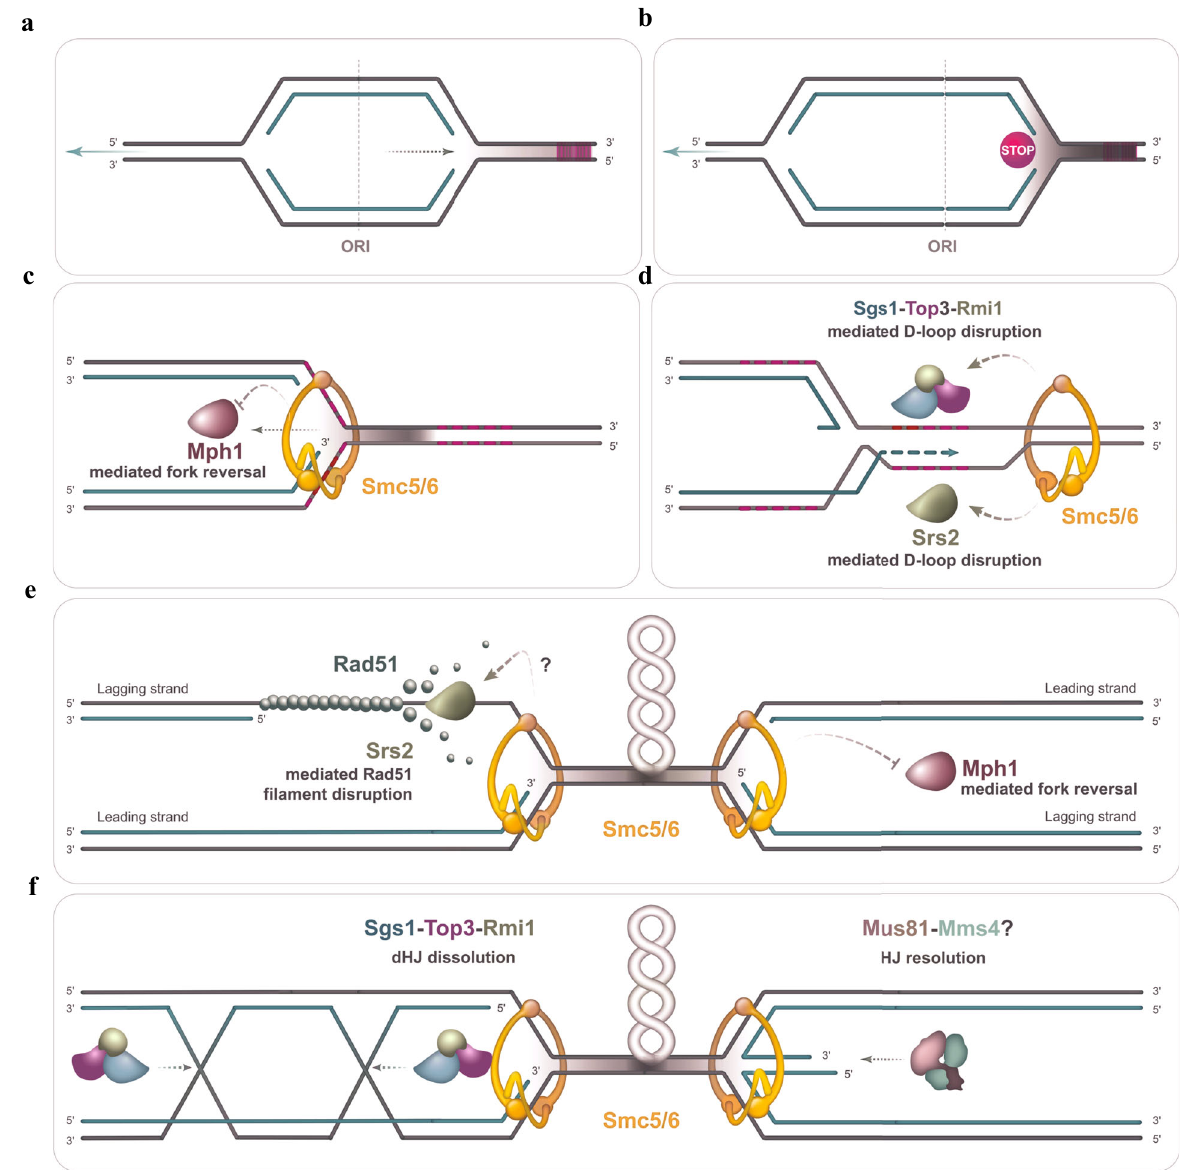
Fig. 8 Schematic representation of Smc5/6 roles in coordinating STR and other DNA crossed strand processing enzymes upon pausing of replication forks at natural pause sites. The upper panel shows replication forks progressing normally ( a ) and one fork pausing as it begins traversing elements at a NPS shown in dashed red lines ( b ). Upon fork stalling, Smc5/6 is shown to inhibit the fork regression activity of Mph1 ( c ) and to promote Srs2 and Sgs1 – Top3 – Rmi1-mediated disruption of displacement loops (D-loops) ( d ). In panel d , the D-loops are shown to form by toxic strand invasion, presumably generated upon fork reversal, into repetitive regions (shown as dashed red lines) present in the non-replicated DNA ahead of the stalled fork. As replication forks converge, Smc5/6 may act to manage associated topological stress and prevent formation of recombination intermediates and reversed forks by regulating Srs2 and Mph1, respectively ( e ). At converging forks, in the context of matured recombination structures ( f ), Smc5/6 is shown to facilitate STR complex in processing double Holliday Junctions (dHJs) and Mus81 – Mms4 in resolving reversed forks, resembling single Holliday